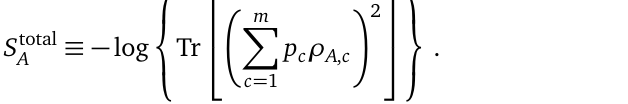
Figure 8: The dynamics of the entanglement entropy S measurement rate. Different curves have different γ in the unit of J . Here, U = J = 6, and the number of bosons N and the number of sites N s = 3. The density matrix is evolved by the single-copy master equation the size L A Eq. ( 8 )